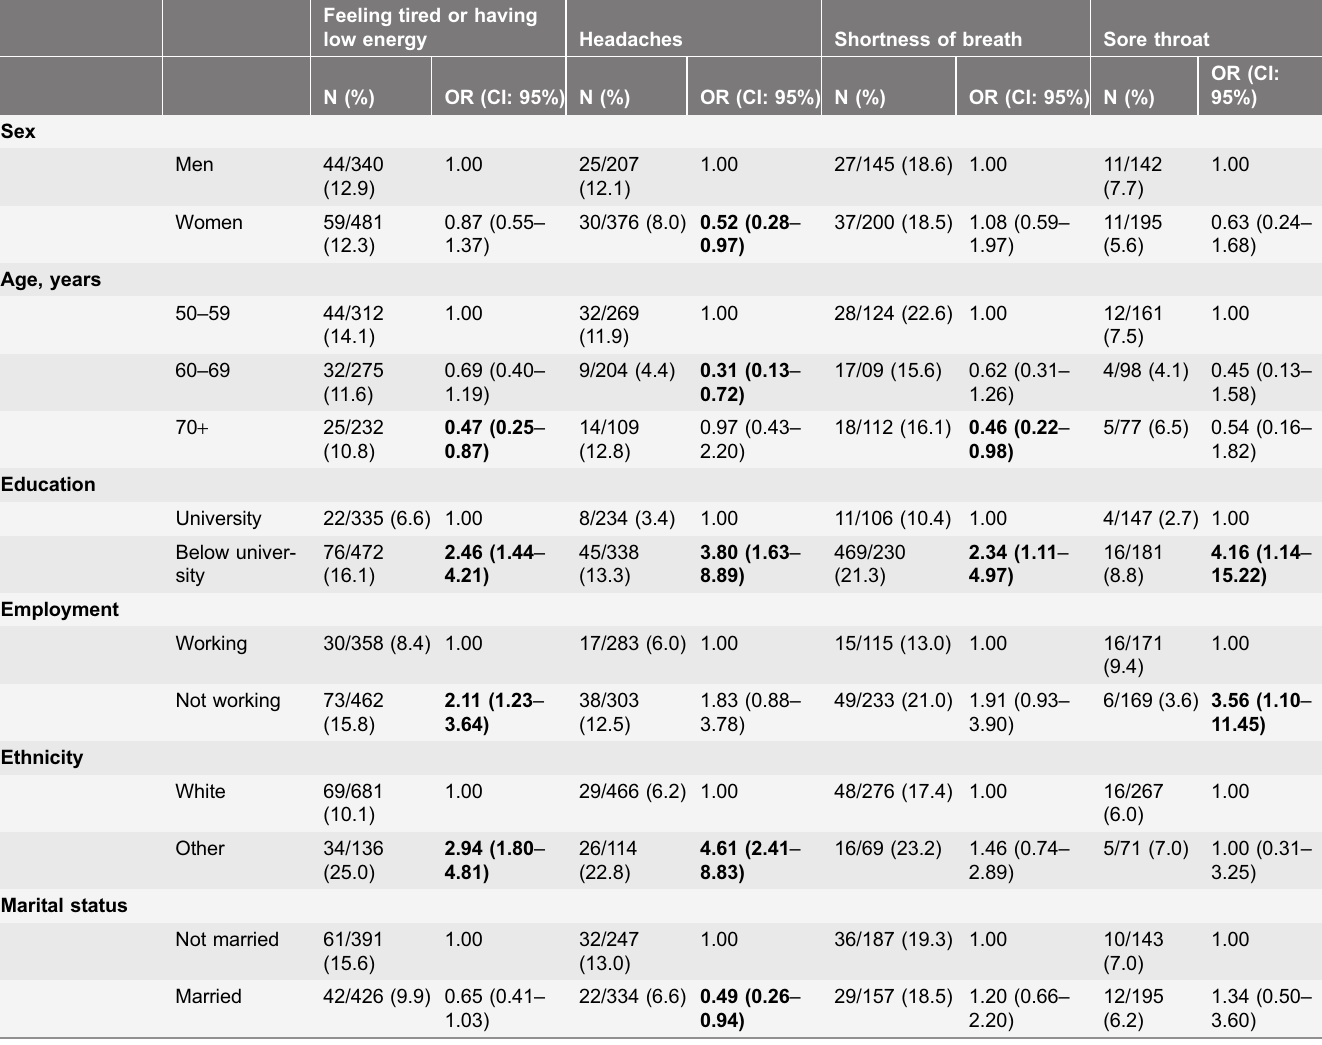
Table 6. Prevalence and adjusted odds ratios of reporting higher perceived seriousness for feeling tired, headaches, shortness of breath and sore throat in the last 3 months.* Feeling tired or having low energy